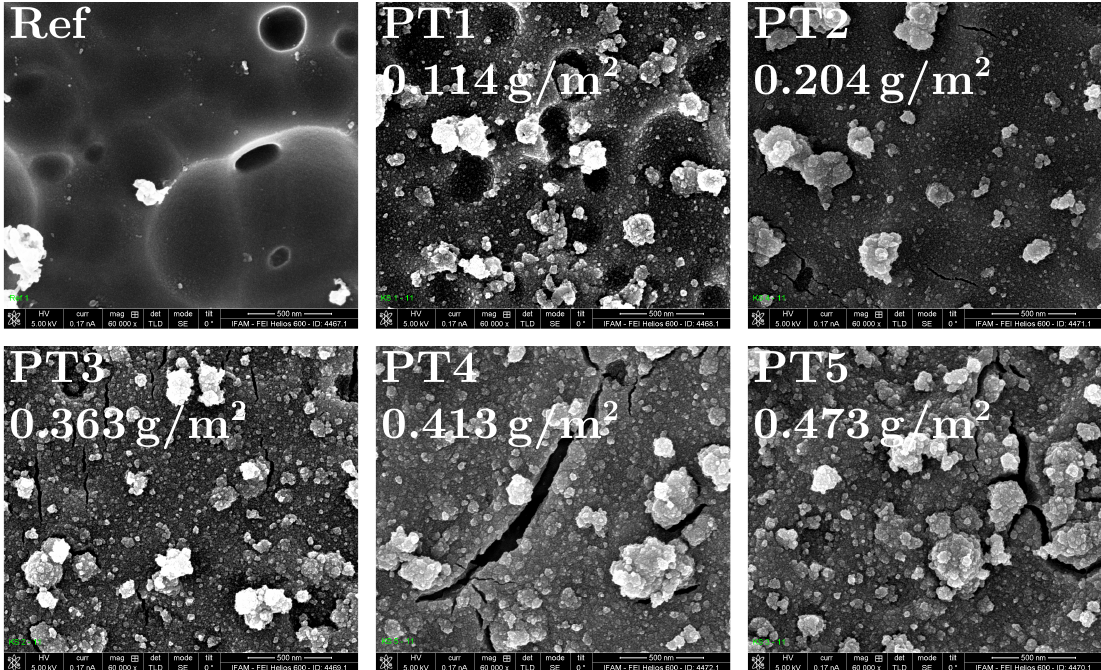
Figure A2. Investigation of the samples by means of SEM with a magnification of 60,000. In Figure A3a an additional SEM image of the Ref sample is shown. Pickling pits as well as grooves induced by the industrial rolling process are clearly distinguishable. Part b of Figure A3 depicts the corresponding 2D-DFT (discrete Fourier transform) of the SEM image with centered origin of the spectrum. Dominate frequencies are observable along a line that is rotated 20 ◦ with respect